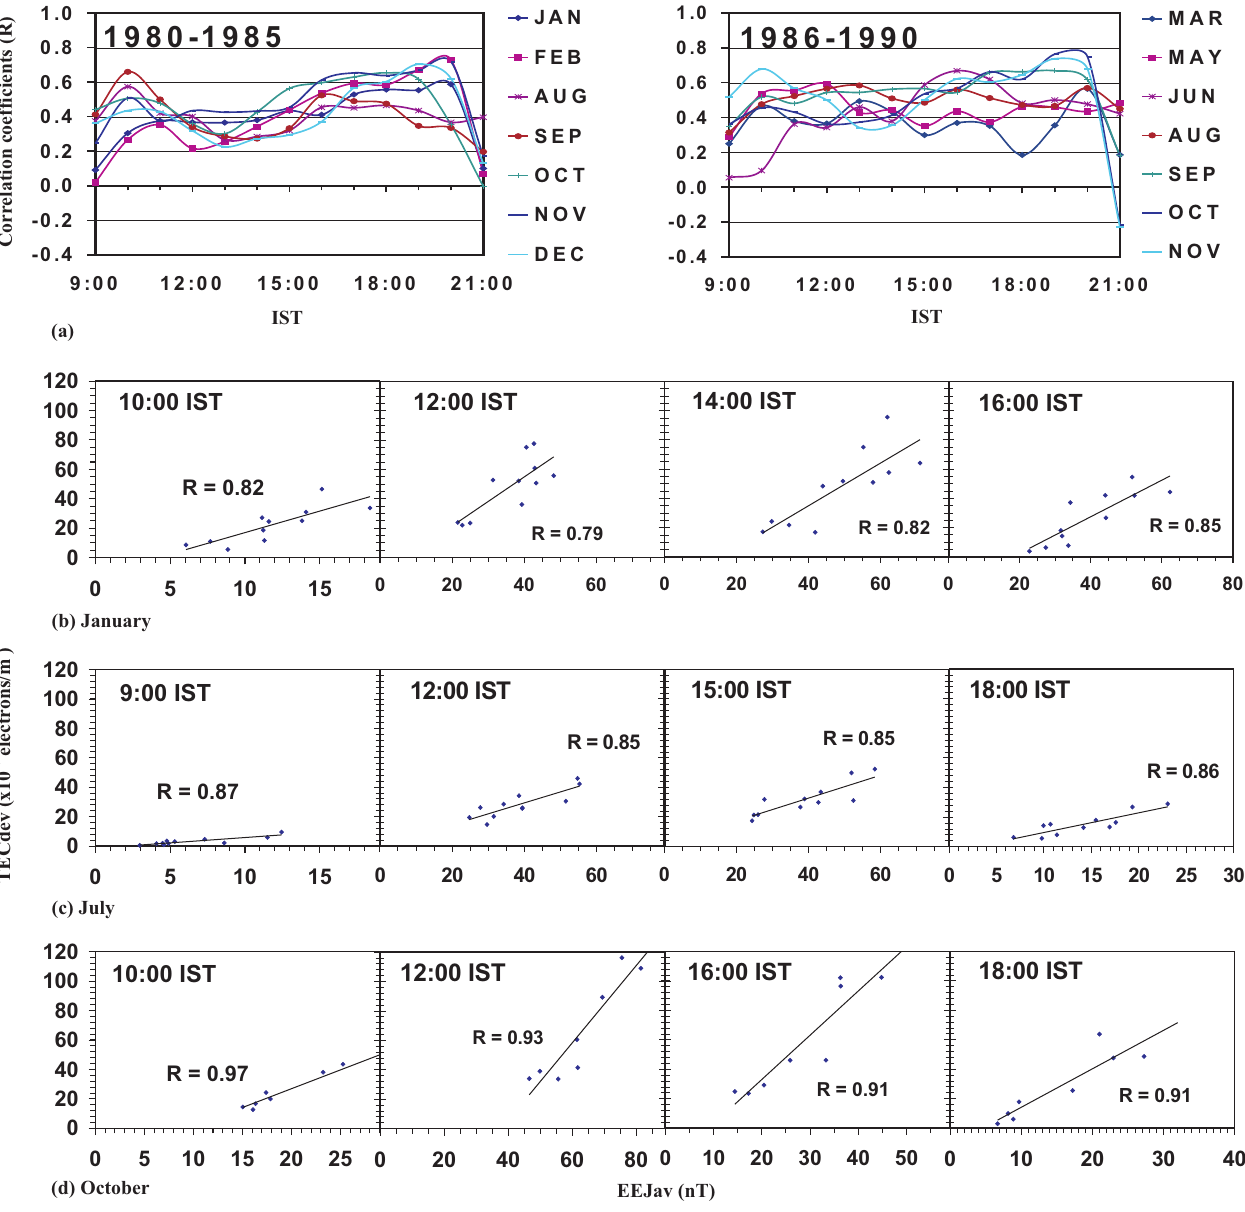
Fig. 5. (a) Plots of diurnal variations in correlation coefficients ( R ) between TEC deviations and EEJ strength with a time delay of 2h for two phases of solar cycles and for the months as indicated. The deviations at a particular time are calculated from solar flux normalized TEC values at 08:00–09:00IST. Panel (b) shows the deviations of monthly mean TEC at the specified time vs. monthly mean EEJ strength at 2 hrs earlier time for the month of January. For the months of July and October the same are plotted in panels (c) and (d) ,